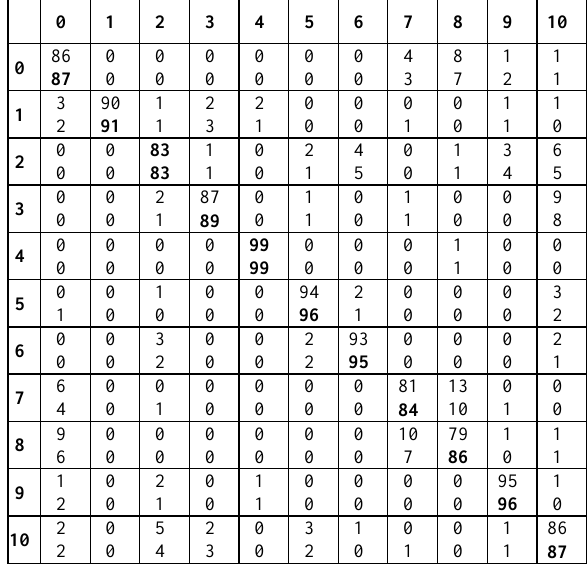
Table 2. Normalized confusion matrix (in %) for RF classifier (first value), GB classifier (seconde one) Variable importance assessment is another interesting aspect to study when applying data mining techniques. Even if the predictors are chosen to be able to better characterize the data without redundancy, we highlighted caveats: someone can have similar and likely collinear information. To see which variable have bigger importance, we compute the corresponding reduction of predictive accuracy when the studied variable is not used on top. In RF, the Gini importance index is defined as the averaged Gini decrease in node impurities over all trees in the forest. As we identified, the most important predictors were RGB channels and Surface density, illustrated in Figure 10 . This shows the importance of 3D geometric feature over 2D feature